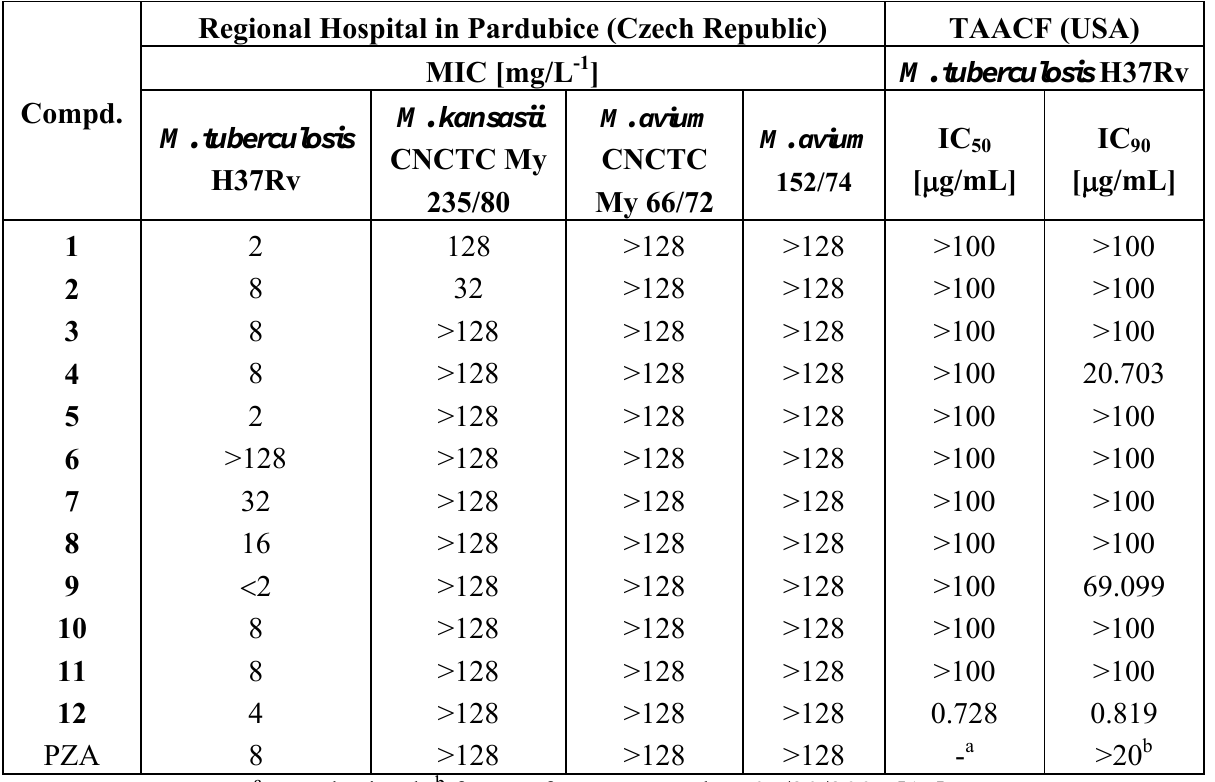
Table 1. Antimycobacterial activity (MIC, IC 1-12 in comparison with standard